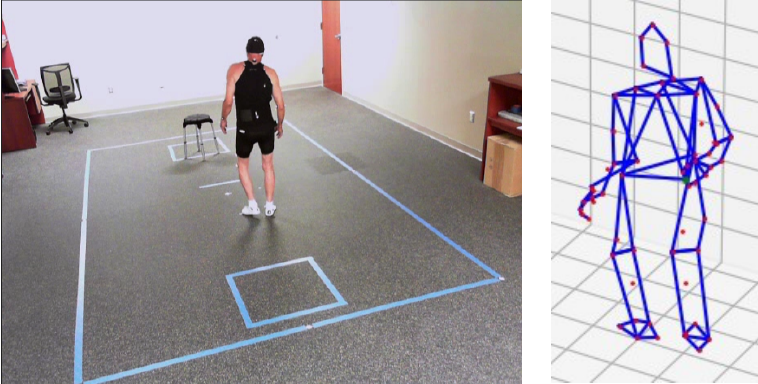
Figure 1. Motion capture recording during timed-up-and-go testing. Left : clinical motion capture laboratory. Right : example of kinematic marker data. Participants were instructed to rise from the stool, walk to the taped box, and return three times during each